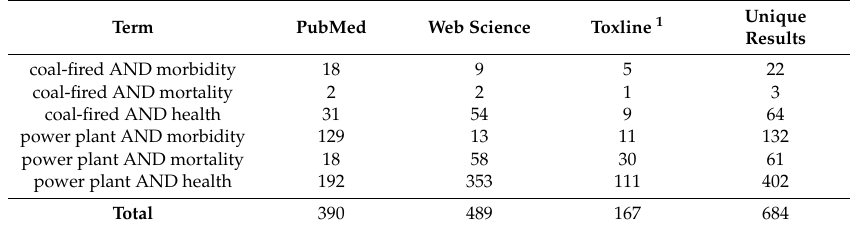
Table 1. Search terms and query results.